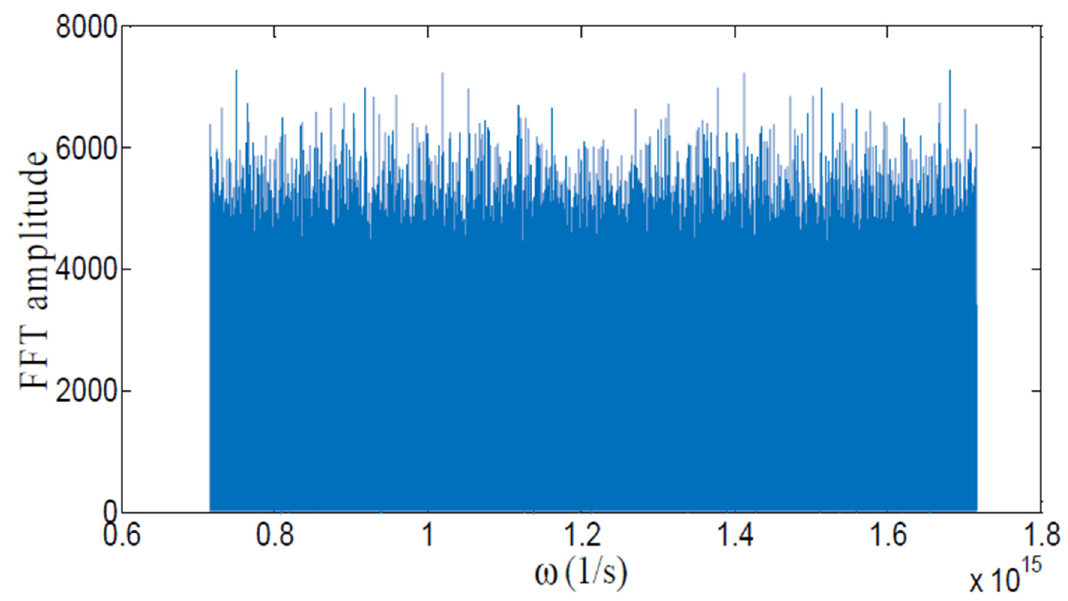
Figure 1. The modulus given in Au of the amplitude spectrum resulting from the (FFT) algorithm computed at Ze = 2 m for the electric-field amplitude of a laser pulse of input maximum power 1.8 W, duration of 1 × 10 − 7 s, and a modulating frequency of 1.2 GHz.